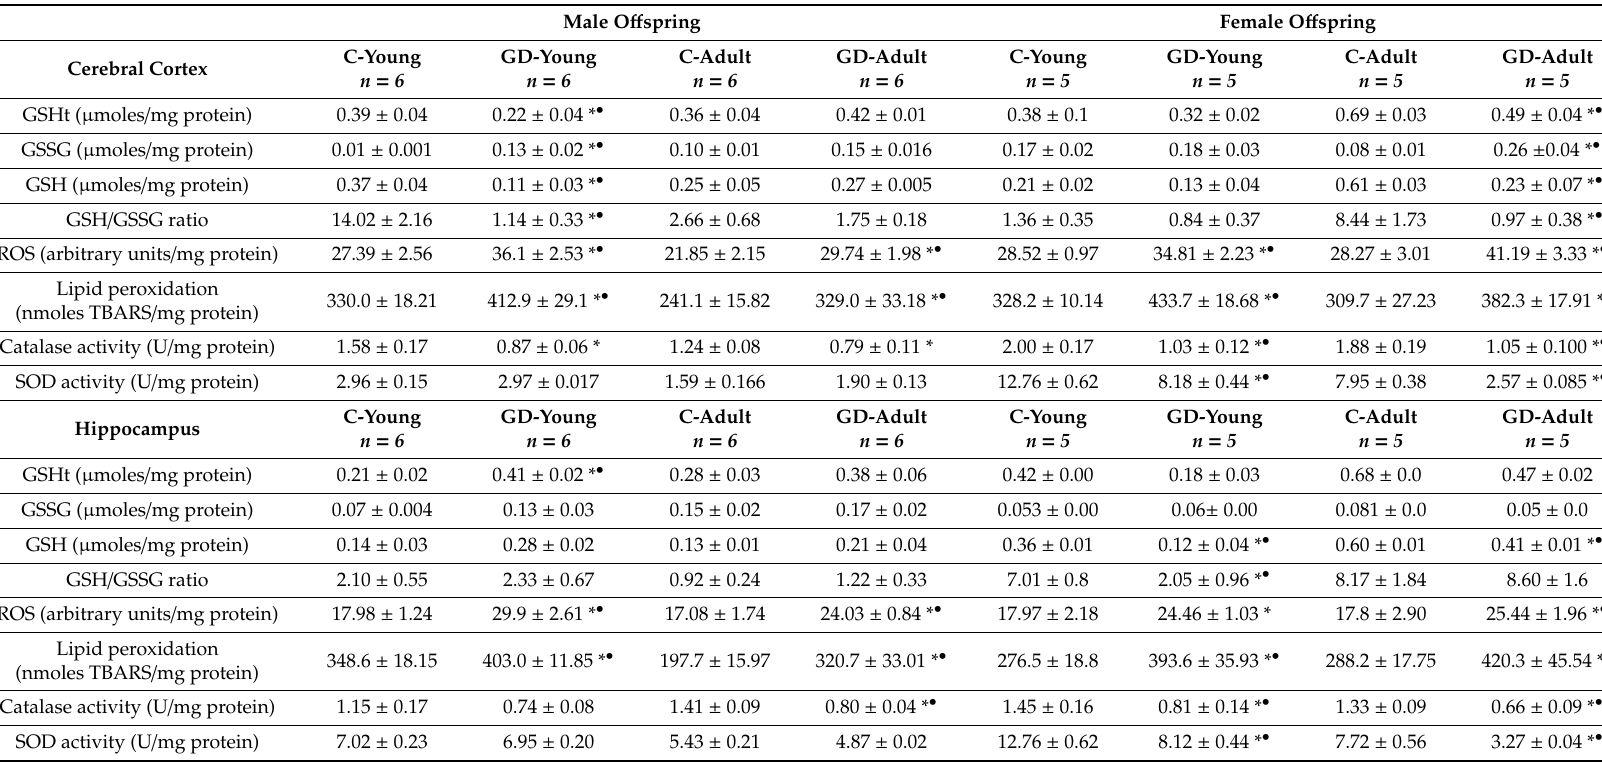
Table 3. Oxidative stress biomarkers. E ff ect of gestational diabetes in oxidative stress biomarkers of cerebral cortex and hippocampus of young and adult, male and female o ff